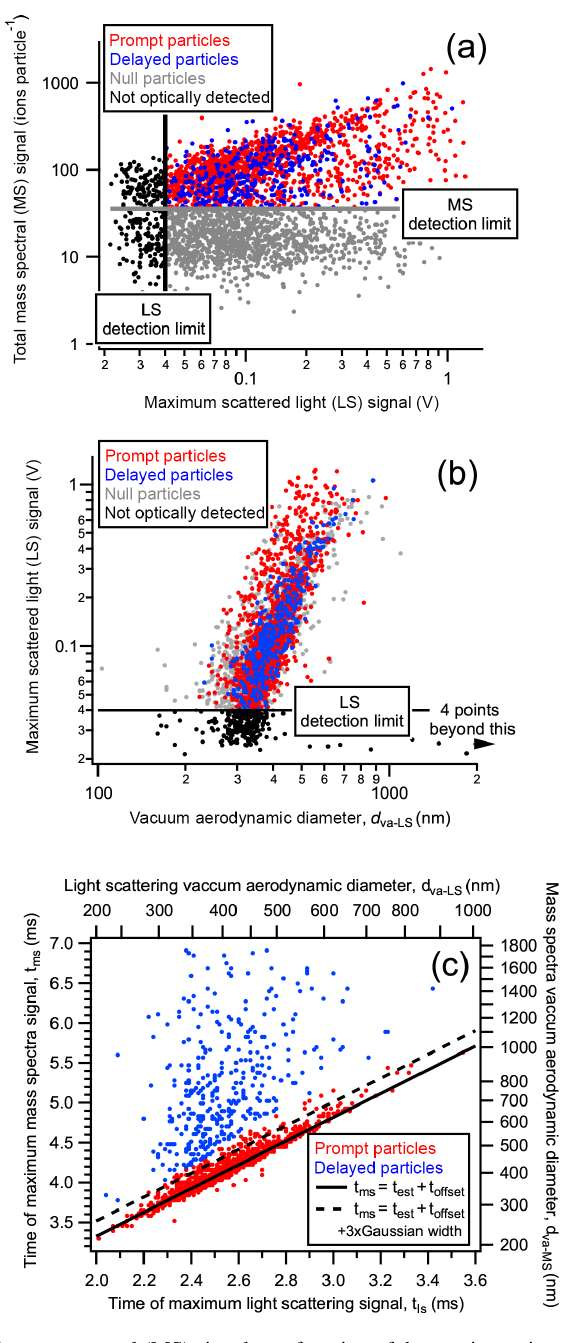
Figure 2. (a) Total LSSP single-particle mass spectral (MS) signal as a function of the maximum intensity of the light-scattering (LS) signal for the data obtained on 6 July 2013. The data are classified by user-specified detection limits and are colored by those below the LS detection limit (black vertical line with black points to the left indicates optically not detected), those below the MS detection limit (gray horizontal line with gray points below indicates null particles), and those defined by the times of the maximum LS and MS signals in Figs. 1 and 2c (red is prompt particles; blue is delayed particles). (b) The maximum scattered light intensity from all LS-triggered events for the flight on 6 July 2013 vs. vacuum aerodynamic diameter from the time of the maximum scattered light intensity, d va-LS . The limit of optical detection was defined for this paper as having a maximum scattered light intensity above 0.04V. Particles with maximum scattered light signals below this are defined as “optically not detected” (black points). Other points are colored as in panel (a) . (c) Time of the maximum mass spectral signal ( t ms ) vs. the time of the maximum scattered light intensity ( t ls ) and their corresponding vacuum aerodynamic diameter d va-MS and d va-LS of all chemically detectable particles (prompt and delayed) from the flight on 6 July 2013. Particles below the chemical (null) and optical detection limits are not included in this plot. In the legend, t est is from Eq. (2) and t offset is the intercept of the solid